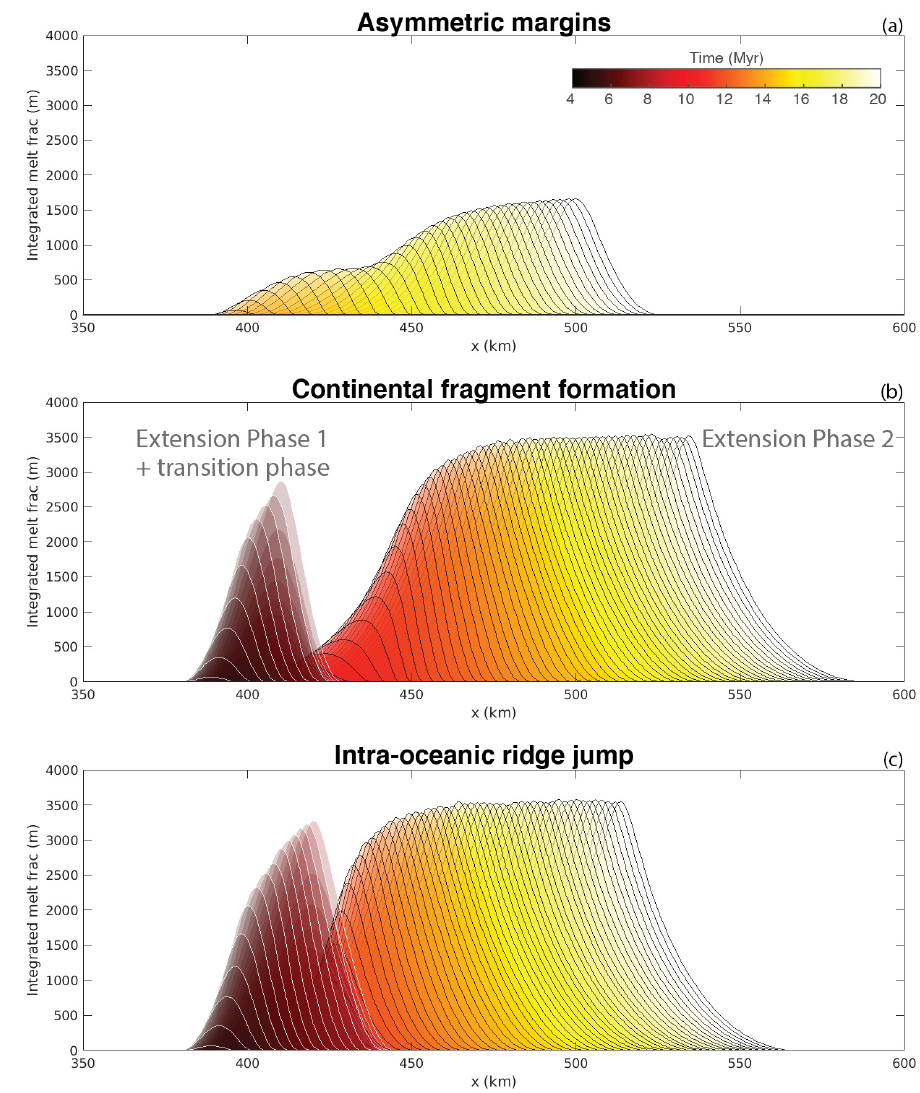
Figure 6. Depth-integrated melt production and location during the three main scenarios: ( a ) Asym- metric margins, ( b ) continental fragment formation, and ( c ) intra-oceanic ridge jump. Each curve corresponds to a time step with an interval of 0.5 Myr in ( a ) and 0.2 Myr in ( b , c ). Peaks on the left with darker colours show location and amount of melt during the first phase of extension and the pause in extension. All models show a clear jump between the location of spreading ridge (or rift) during phase 1 and location of the spreading ridge in phase 2.